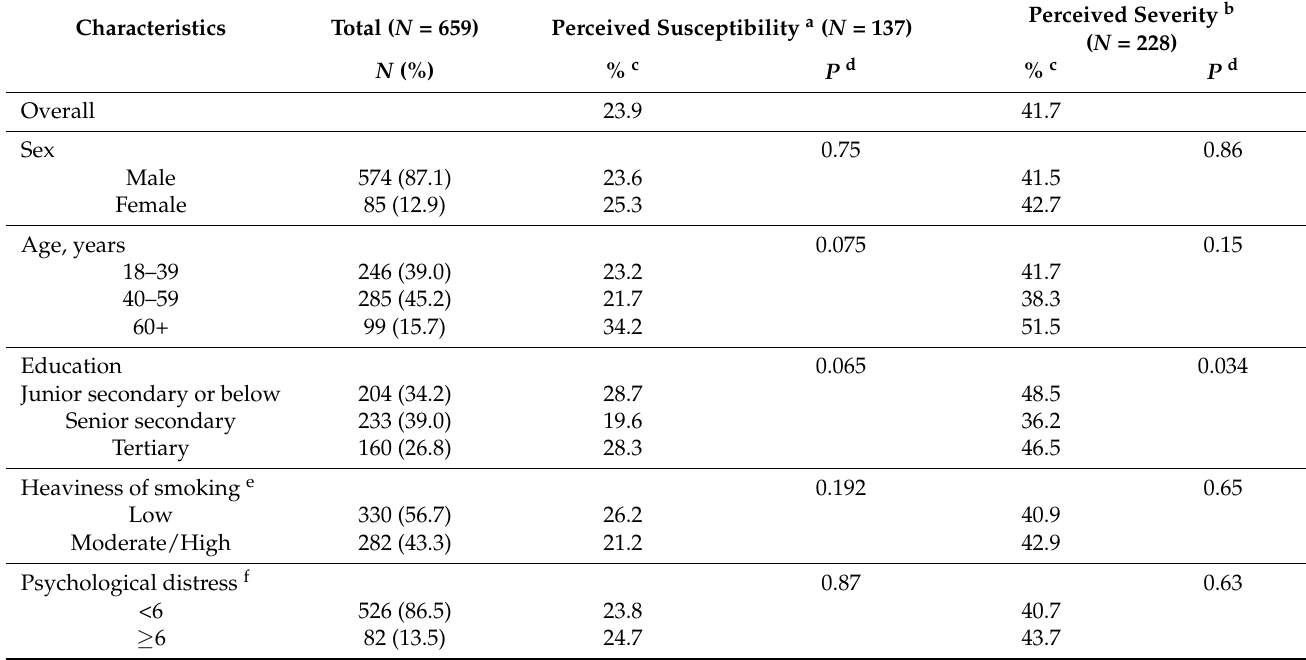
Table 1. Prevalence of high perceived susceptibility to and severity of COVID-19 in relation to smoking according to participants’